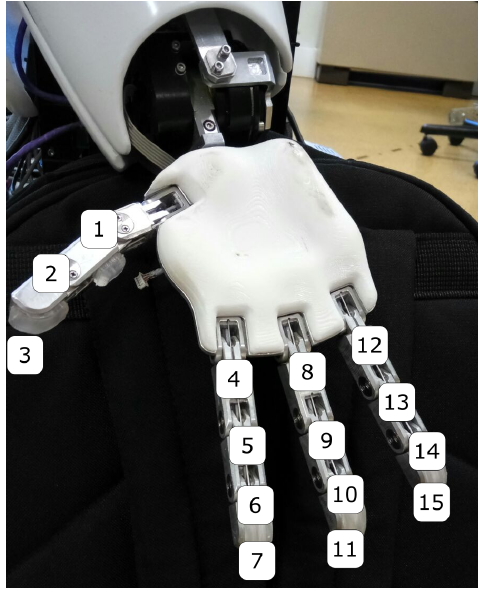
Figure 3: Indexes of the force sensors in our robot’s hand. Sensors 12 to 15 are still on testing phase and will only be used in future